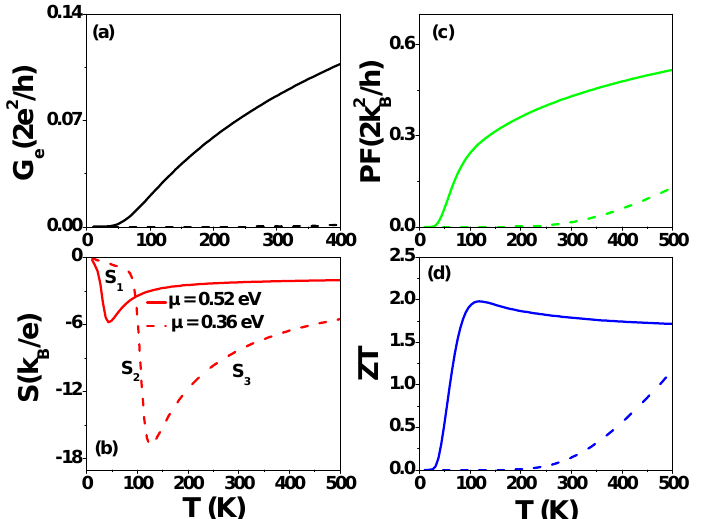
Figure 10. ( a ) Electrical conductance G e , ( b ) Seebeck coefficient S , ( c ) power factor PF , and ( d ) figure of merit ZT of SGQD with N z = 5 and N a = 132 ( N QD = 15) as functions of temperature for different µ at Γ t = 2.7 eV. The phonon thermal conductance ( κ ph ) adopted is the same as in Figure